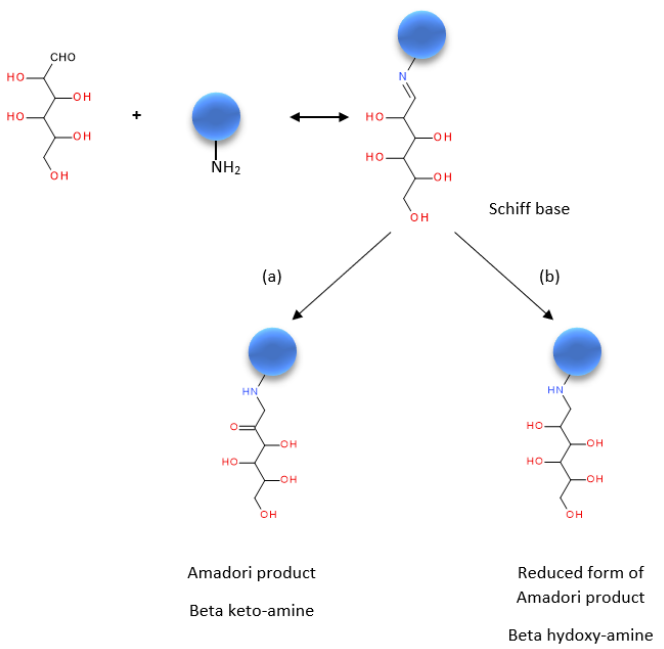
Figure 1. A Maillard reaction between a protein and dextrose [29,35,56–58] ( a ) under non-reducing conditions and ( b ) under reducing conditions. Blue spheres: